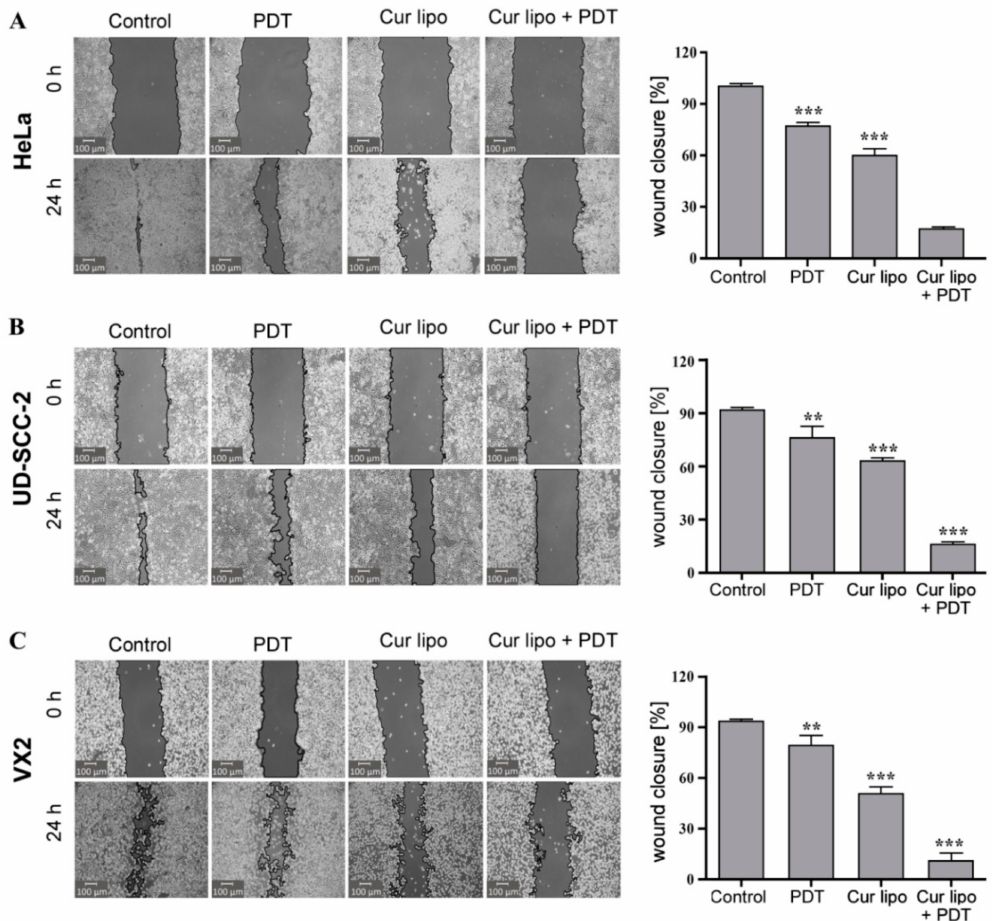
Figure 6. Cell migration (wound healing) assay in HeLa, UD-SCC-2, and VX2 cells. HeLa ( A ), UD-SCC-2 ( B ), and VX2 ( C ) tumor cells were treated with photodynamic therapy (PDT) only, curcumin liposomes (Cur lipo) only, or Cur lipo in combination with PDT. Images were captured at t = 0 h directly after scratching the cell layer and t = 24 h to evaluate scratch (wound) closure indicative of cellular migration. The cell-free area of the scratched region was measured with the Montpellier Ressources Imagerie (MRI) wound healing tool used with the ImageJ analysis software [41]. The level of cell migration is presented as the percentage of scratch (wound) closure observed 24 h after treatment compared to control values. Controls indicate untreated cells. The values are expressed as the mean ± standard deviation, and statistical significances are indicated as *** p < 0.001, ** p <